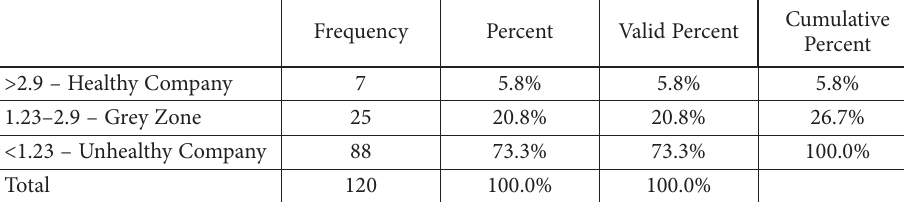
Table 9. Frequency of Altman Z-Score (source: author based on Bisnode